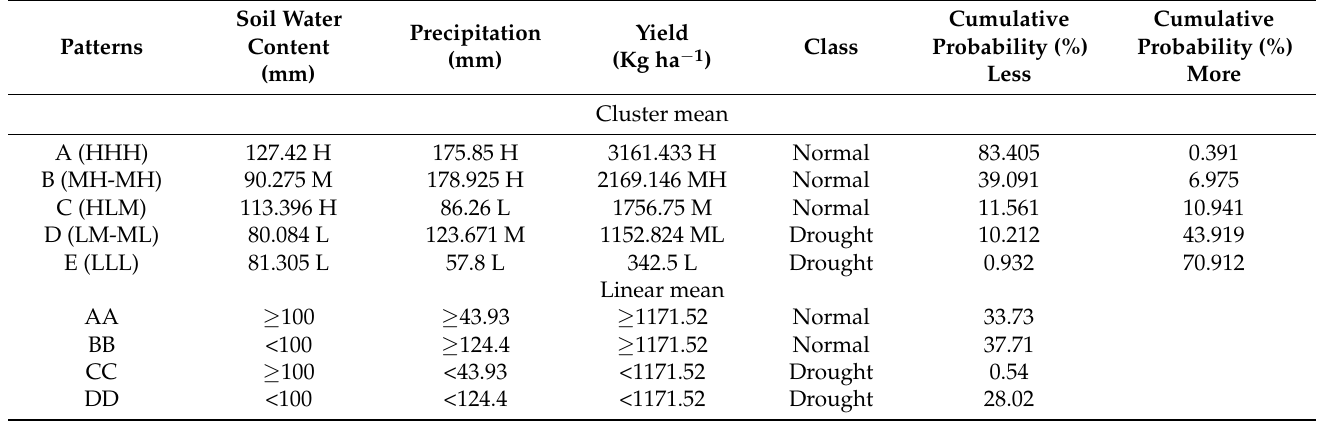
Figure 4. Cluster analysis for spring wheat yield during the period 1987–2011 in Dingxi, Gansu Province, China. The ANOVA analysis of the spring wheat yield, soil water content at planting, and growing season precipitation for different climatic patterns is shown in Table S2. Table 4. Mean values of spring wheat yield, soil water content at planting, and precipitation during spring wheat growing season according to a specific cluster. H, M, and L indicates high, middle, and low levels, respectively.